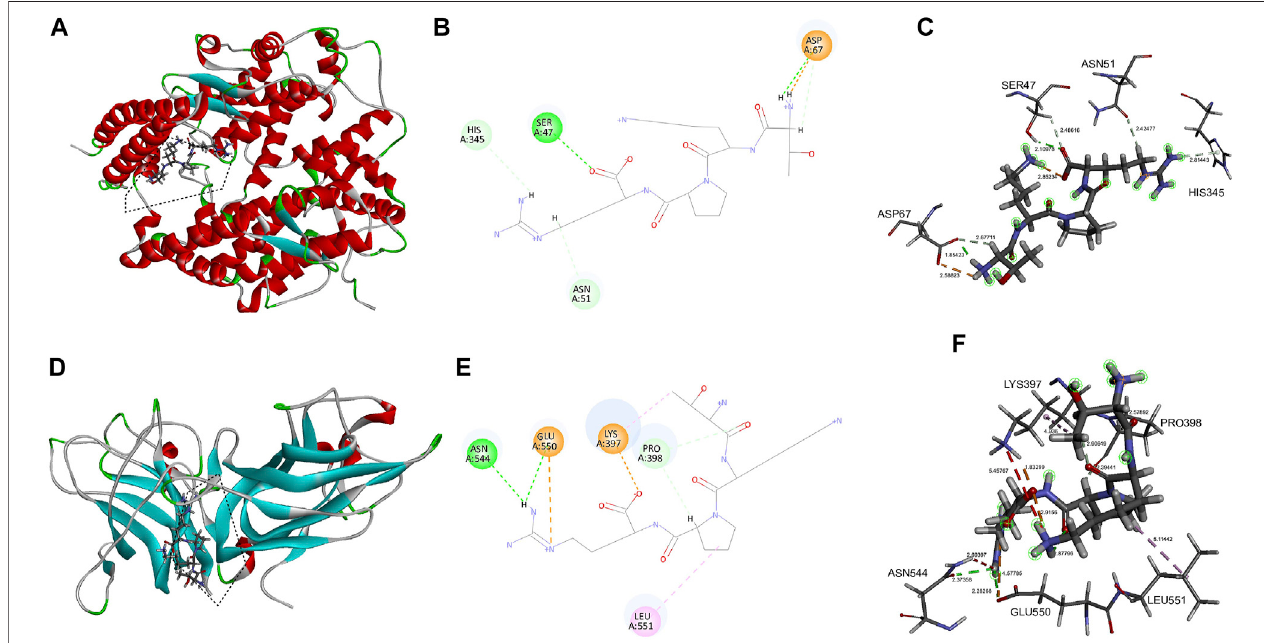
FIGURE 2 | Molecular interaction of tuftsin with ACE2 and NRP1. (A) The binding pattern of tuftsin with ACE2. Binding area was circled by black dotted line. Secondary structural elements are depicted as ribbons (coils, α -helices, arrows, β -sheets). Color is based on secondary structures ( α -helices, red; β -sheets, skyblue; loops, green). (B) Molecular interaction schemes of tuftsin with the relative residues of ACE2. Green lines represent conventional hydrogen bonds; light green lines represent carbon-hydrogen bonds; orange lines represent salt bridges; and pink lines represent alkyl bonds. (C) The bond lengths of intermolecular interactions between tuftsin and ACE2. The bond length was indicated by the dotted line between the interacted molecules. The bound amino acid residues are shown in stick representation. (D) The binding pattern of tuftsin with NRP1. Binding area was circled by black dotted line. (E) Molecular interaction schemes of tuftsin with the relative residues of NRP1. (F) The bond lengths of intermolecular interactions between tuftsin and NRP1. Other interpretations are the same as